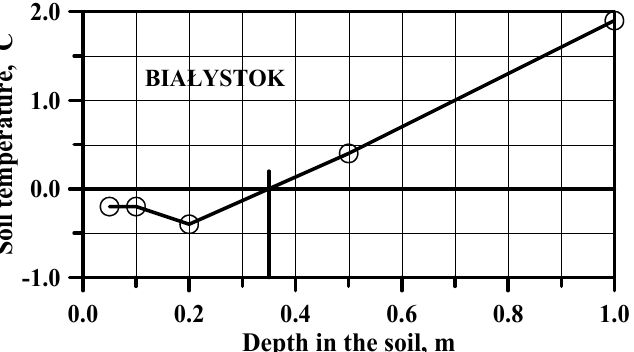
Figure 1. Example of temperature of the soil at the meteorological station in Białystok for one day (15 March 2005) adapted from [19].